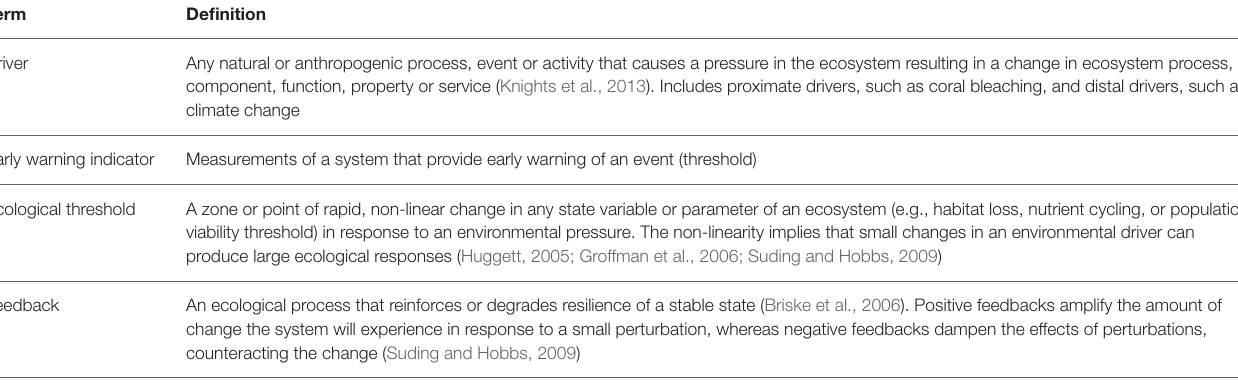
TABLE 1 | Glossary of terms